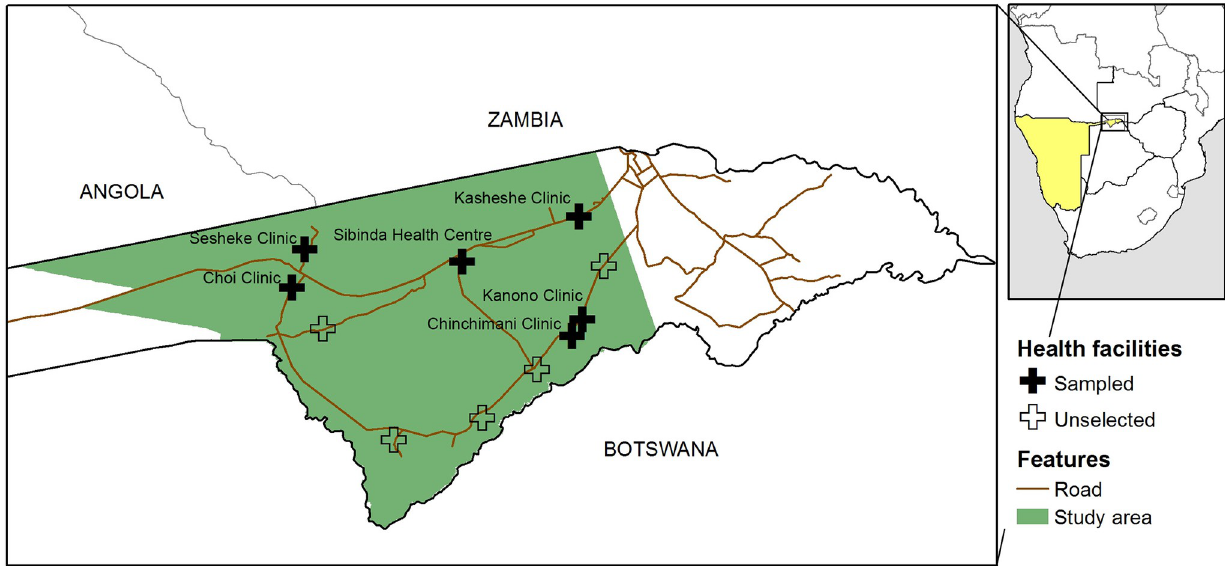
Fig 1. Location of six selected health facilities within the larger study area, Zambezi Region, Namibia.